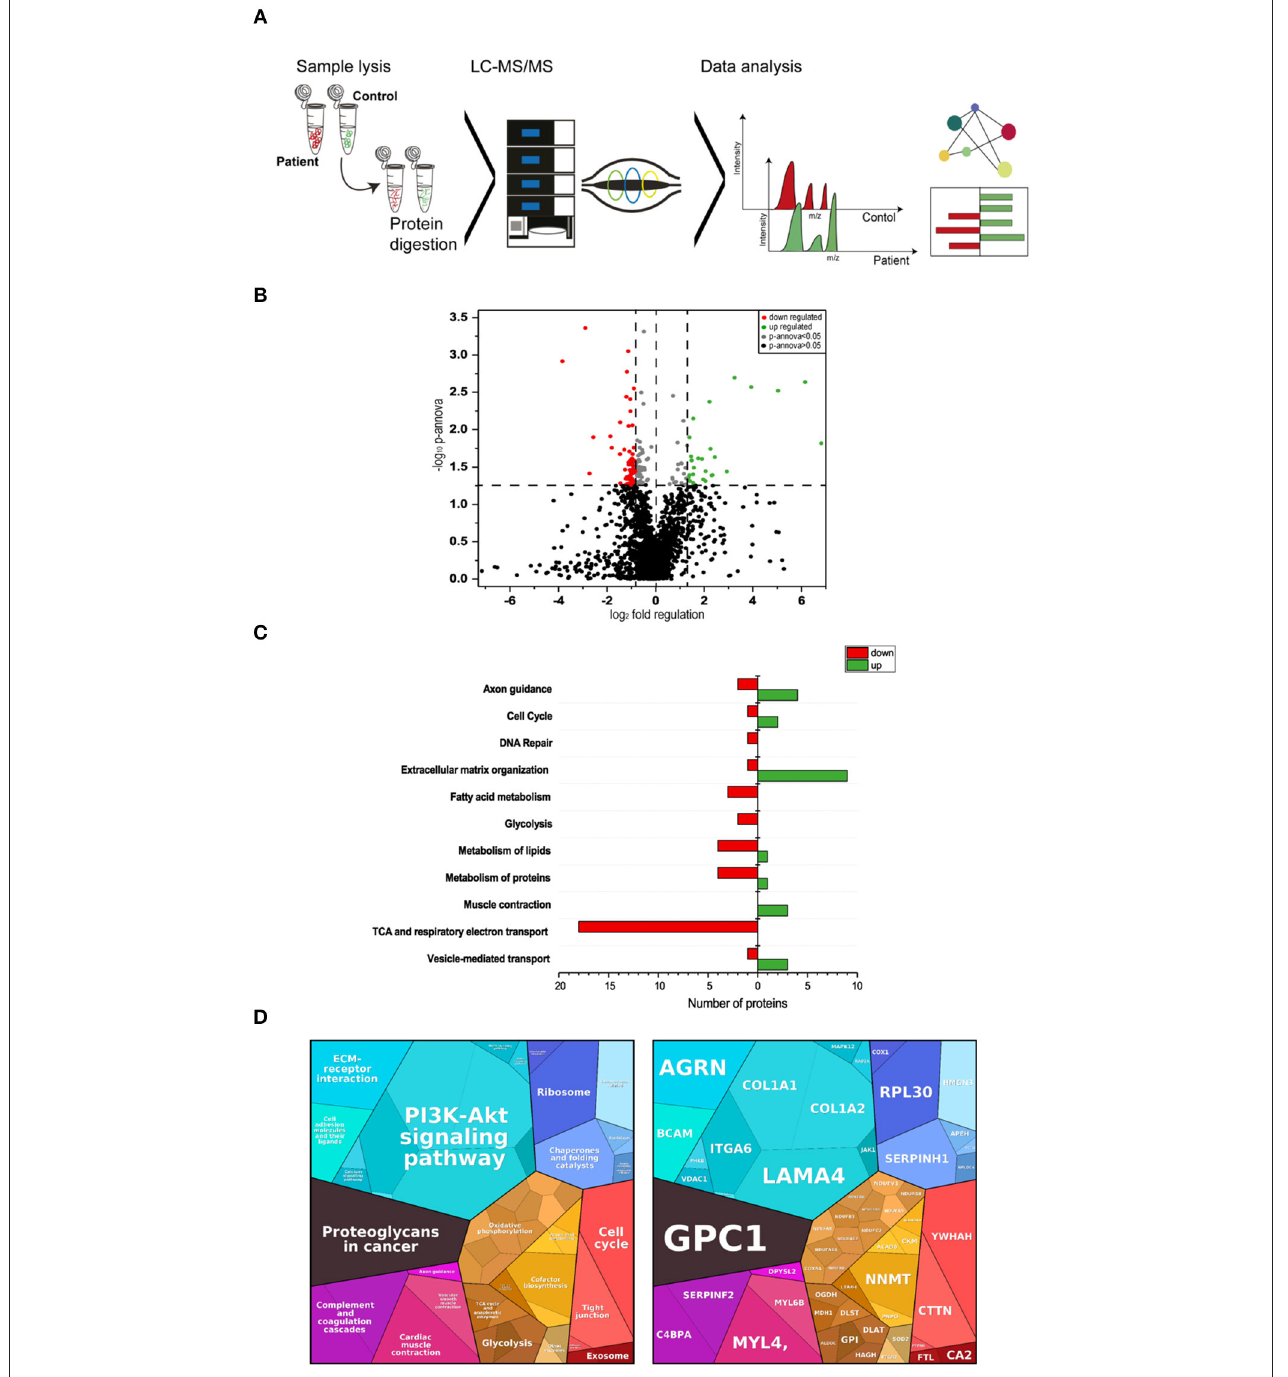
FIGURE 3 | Proteomic profiling of four MDC1A-patient derived muscles. (A) Methodological workflow applied in the study. (B) Results of our label-free proteomic profiling are shown as a volcano plot. All points (each one represents a protein) over the horizontal line have a statistically significant p-ANOVA of ≤ 0.05. In total, 51 proteins are decreased (red points) and 35 proteins are increased in abundance (green points) in laminin-211-deficient skeletal muscle. (C) Results of an in silico pathway analysis of proteins altered in abundance utilizing DAVID, KEGG, and Reactome platforms indicating alterations of ECM protein composition, cellular metabolism, axon guidance, cell cycle, and DNA repair, muscle contraction and of vesicular protein transport. (D) Results of an in silico pathway analysis of proteins altered in abundance utilizing Proteomap platform confirming the perturbed cellular functions indicated by the results of the previous pathway analysis and moreover indicating perturbed function of cellular signaling cascades such as PI3K-Akt